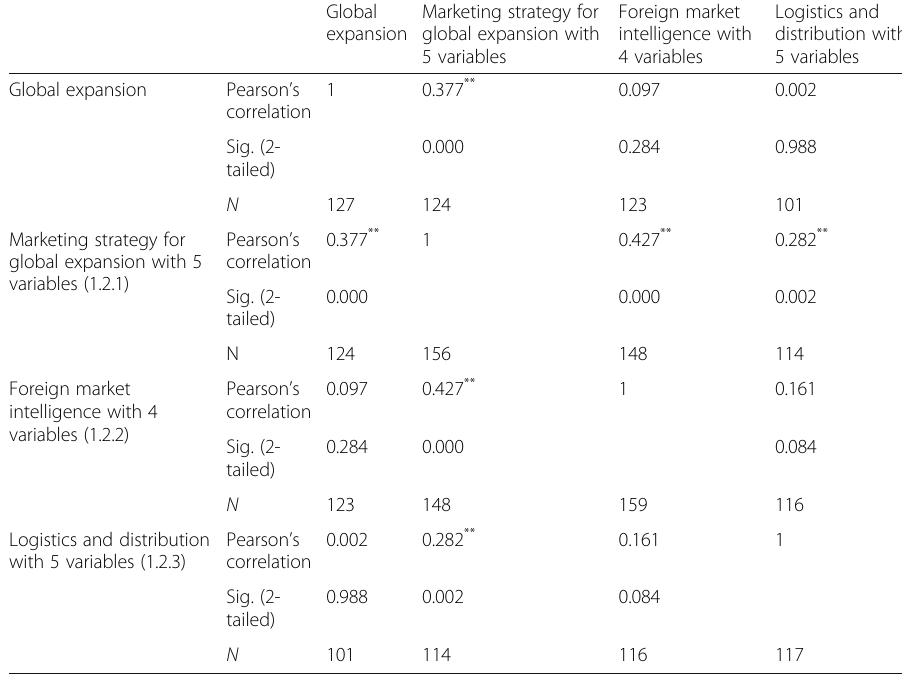
Table 3 Global market strategy: summarised correlations